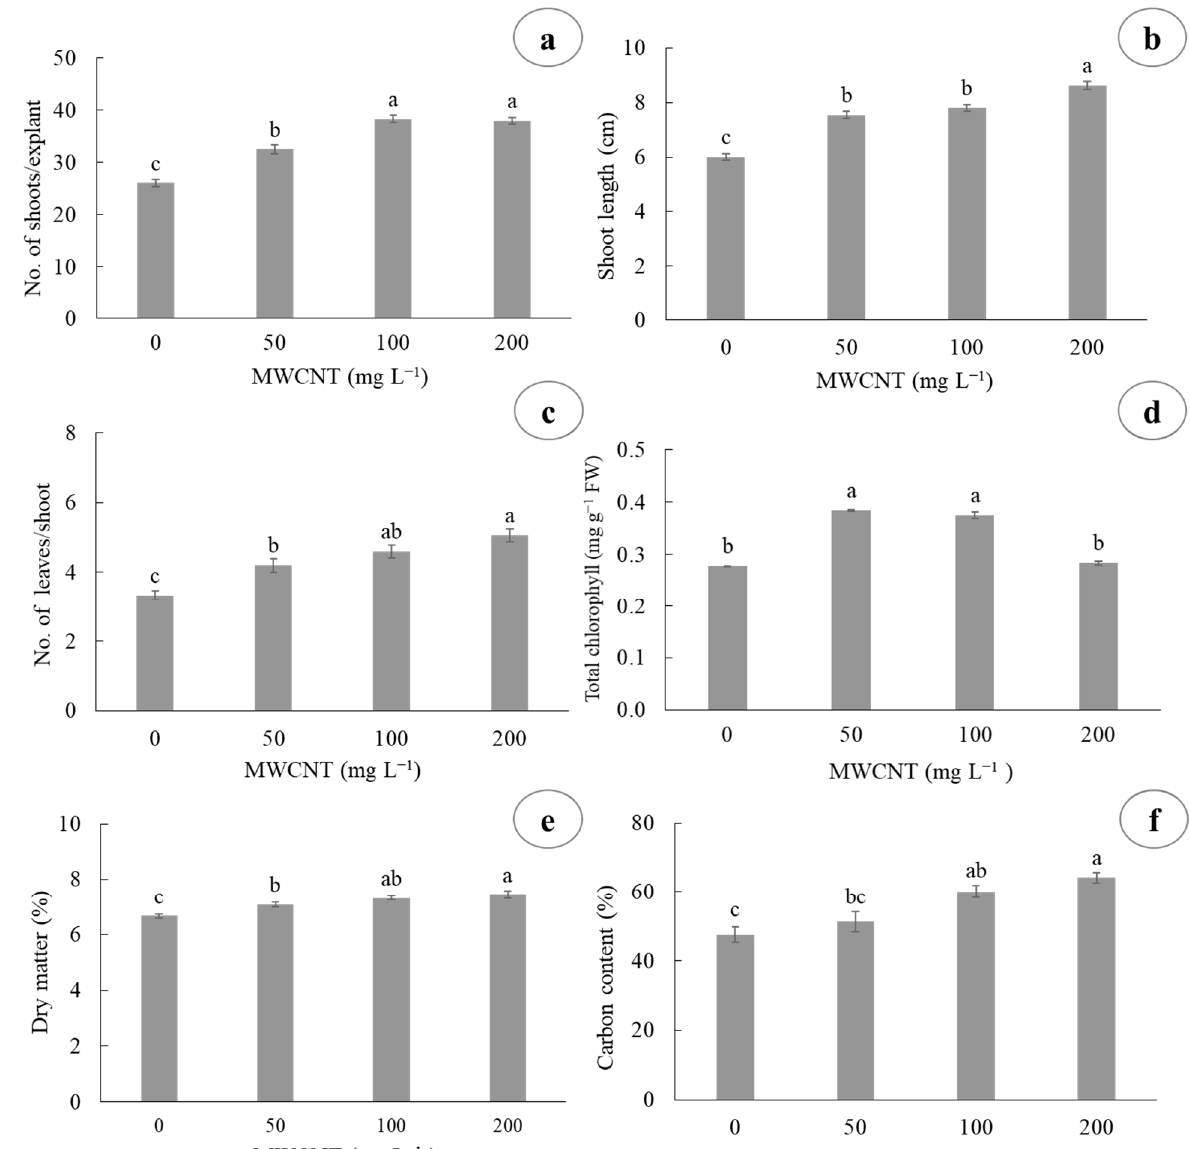
Figure 2. Effect of multi-walled carbon nanotubes (MWCNTs) on shoot development and total chlorophyll and carbon content of sugarcane ( Saccharum spp.) cv. Mex 69-290 cultured in vitro in temporary immersion. ( a ) Shoots per explant, ( b ) shoot length, ( c ) leaves per shoot, ( d ) total chlorophyll, ( e ) dry matter, and ( f ) carbon content at 30 days of culture. Results are shown as mean ± SE (standard error). Means with a different letter are significantly different (Tukey, p ≤